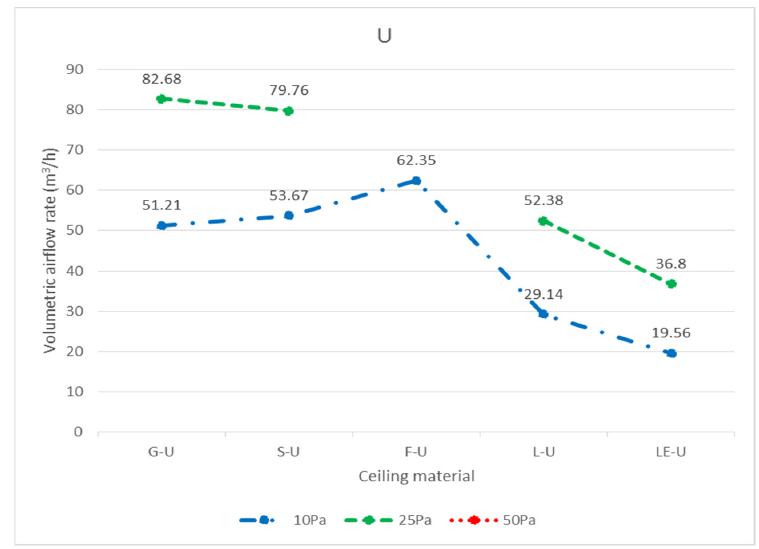
Figure 9. Average leakage volume of each specimen at each pressure difference from bottom to top (U) (m 3 /h).